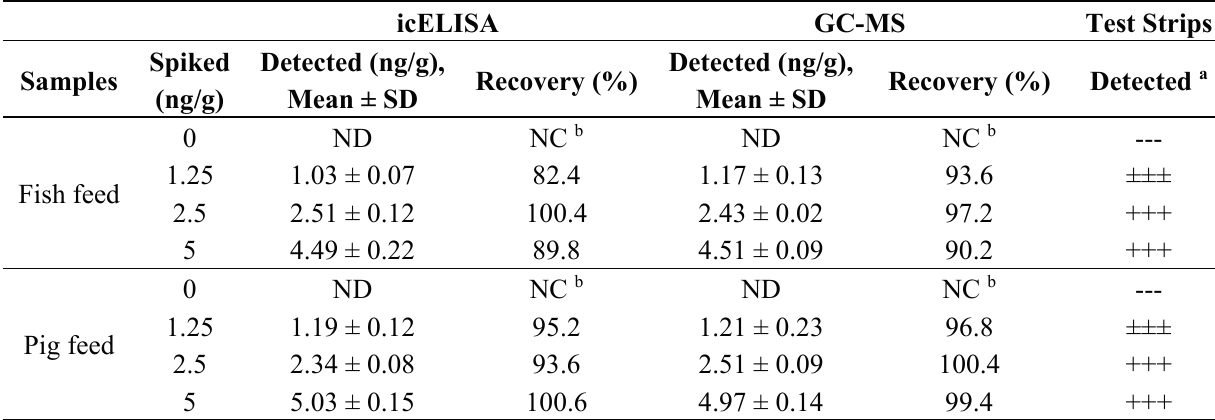
Figure 4. Correlation studies between icELISA and GC-MS detection in fish ( A ) and pig ( B ) feed. These samples were obtained from MT spiked at levels of 1.25, 2.5 and 5 ng/g ( n = 3). Table 2. Comparison of MT analyses by icELISA, GC-MS and immunochromatographic strip in animal feed ( n =